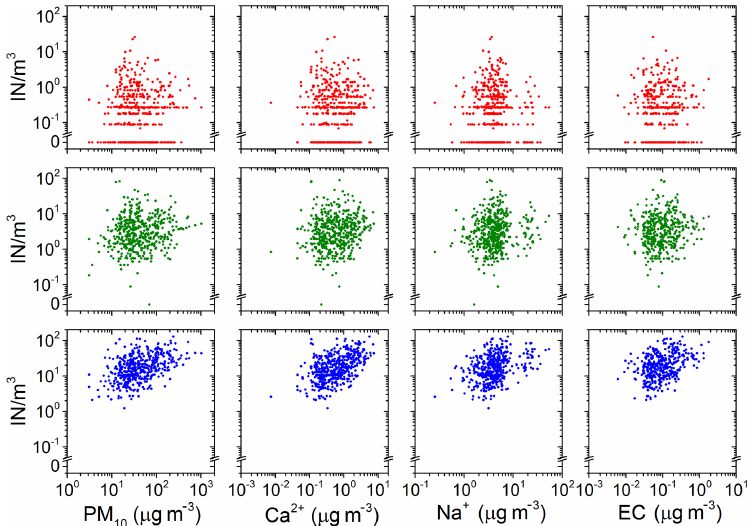
Figure 3. Relation between the concentration of IN at − 8 ◦ C (red), − 12 ◦ C (green), − 16 ◦ C (blue) and total particle mass concentration, mass concentrations of calcium (Ca 2 + ), mass concentration of sodium (Na + ) and mass concentration of elemental carbon (EC). Ca 2 + , Na + and EC are tracers of continental, marine and combustion sources,